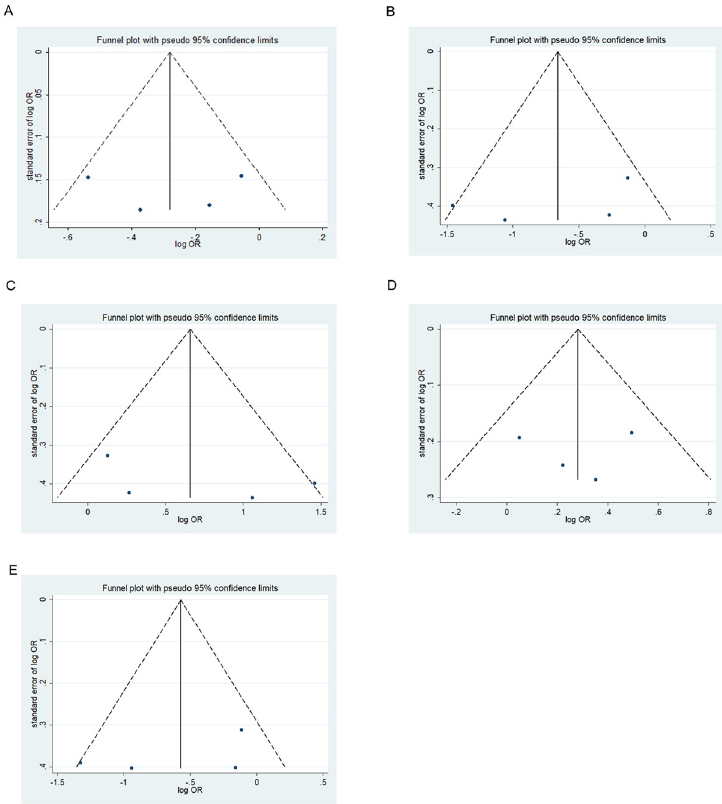
Fig 11. Funnel plot analysis depicting publication bias in the association between MTHFR 1298A > C polymorphism and bipolar disorder in the five genetic models (A, allele contrast; B, homozygous codominant; C, heterozygous codominant; D, dominant; and E,